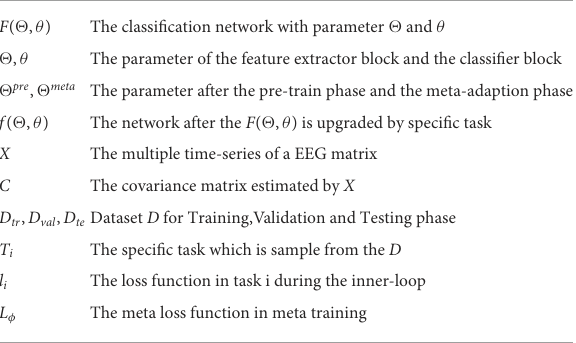
TABLE 2 Table of symbols used in the article. Symbols